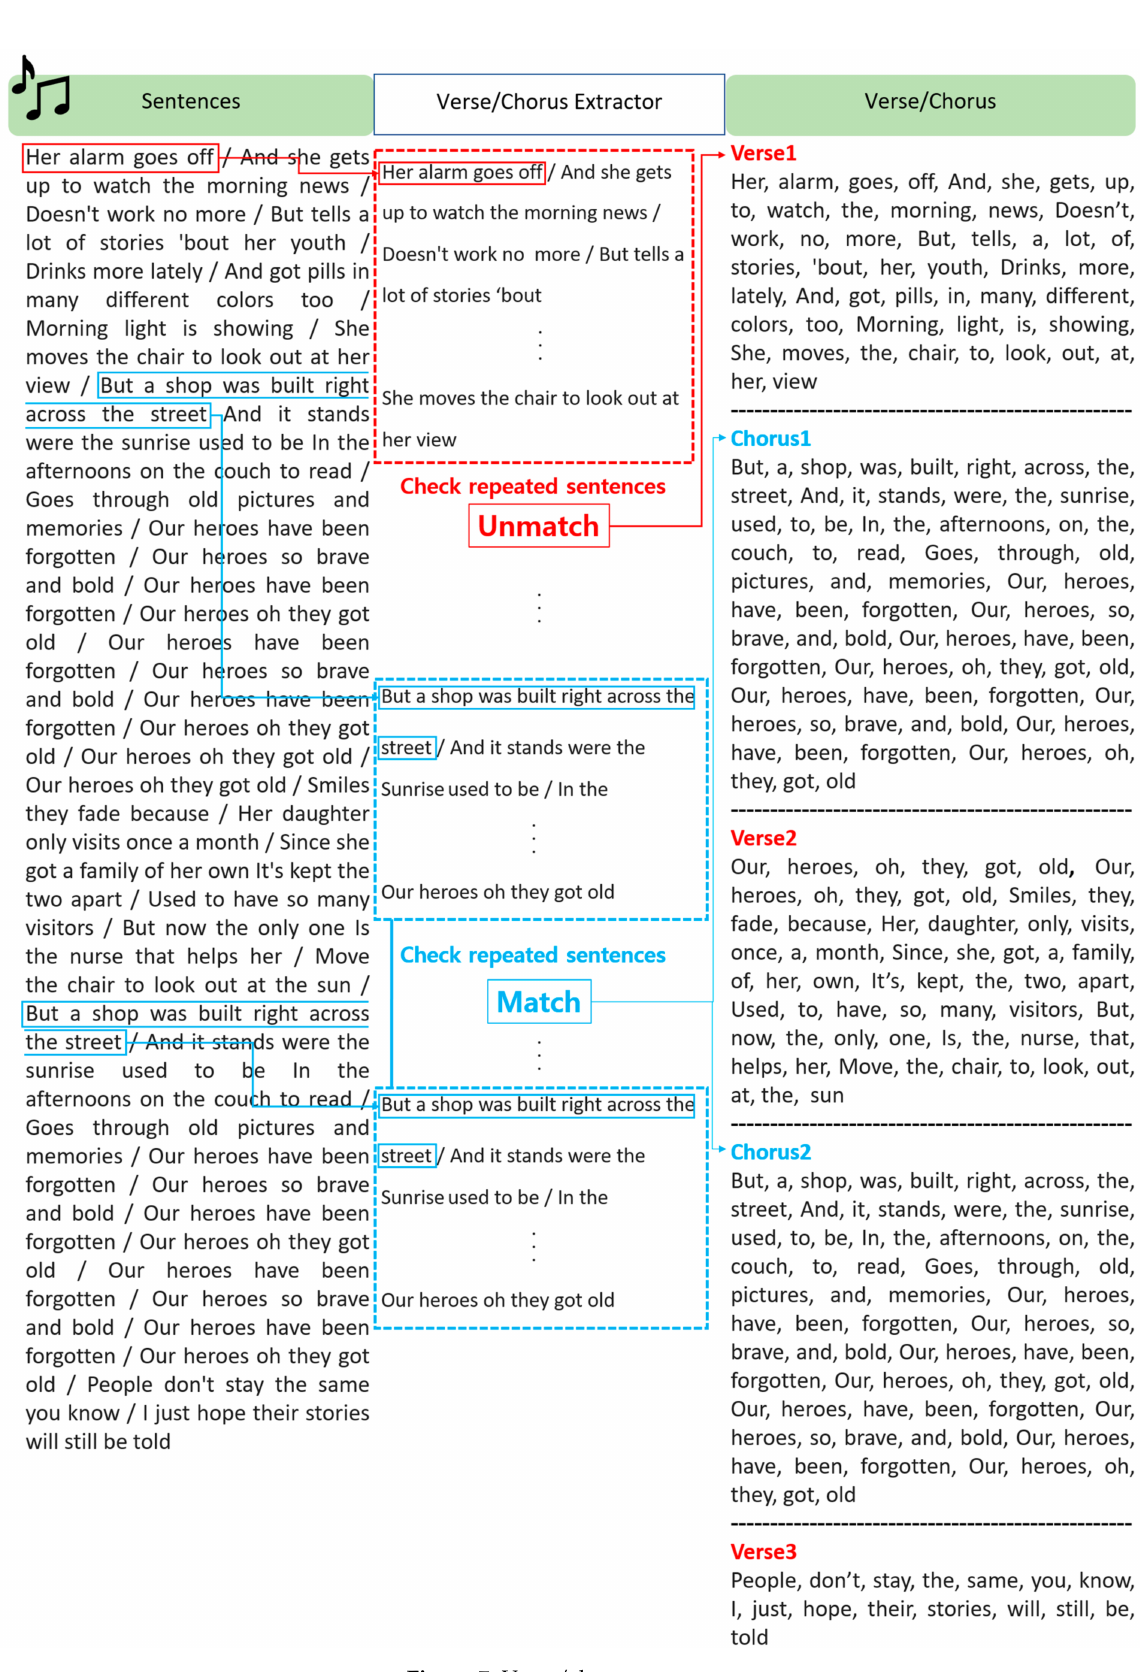
Figure 7. Verse/chorus